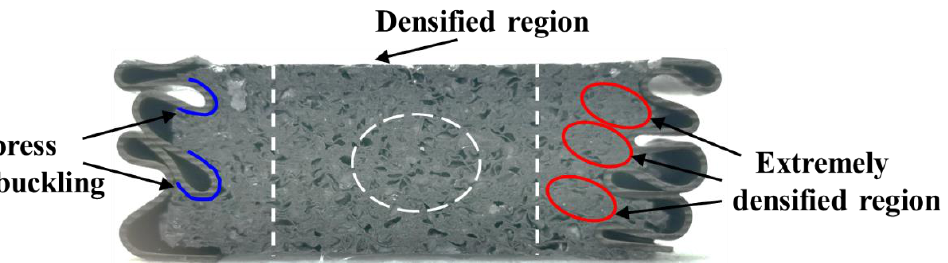
Figure 21. Cut-away image of crushed FLNT-4 section.